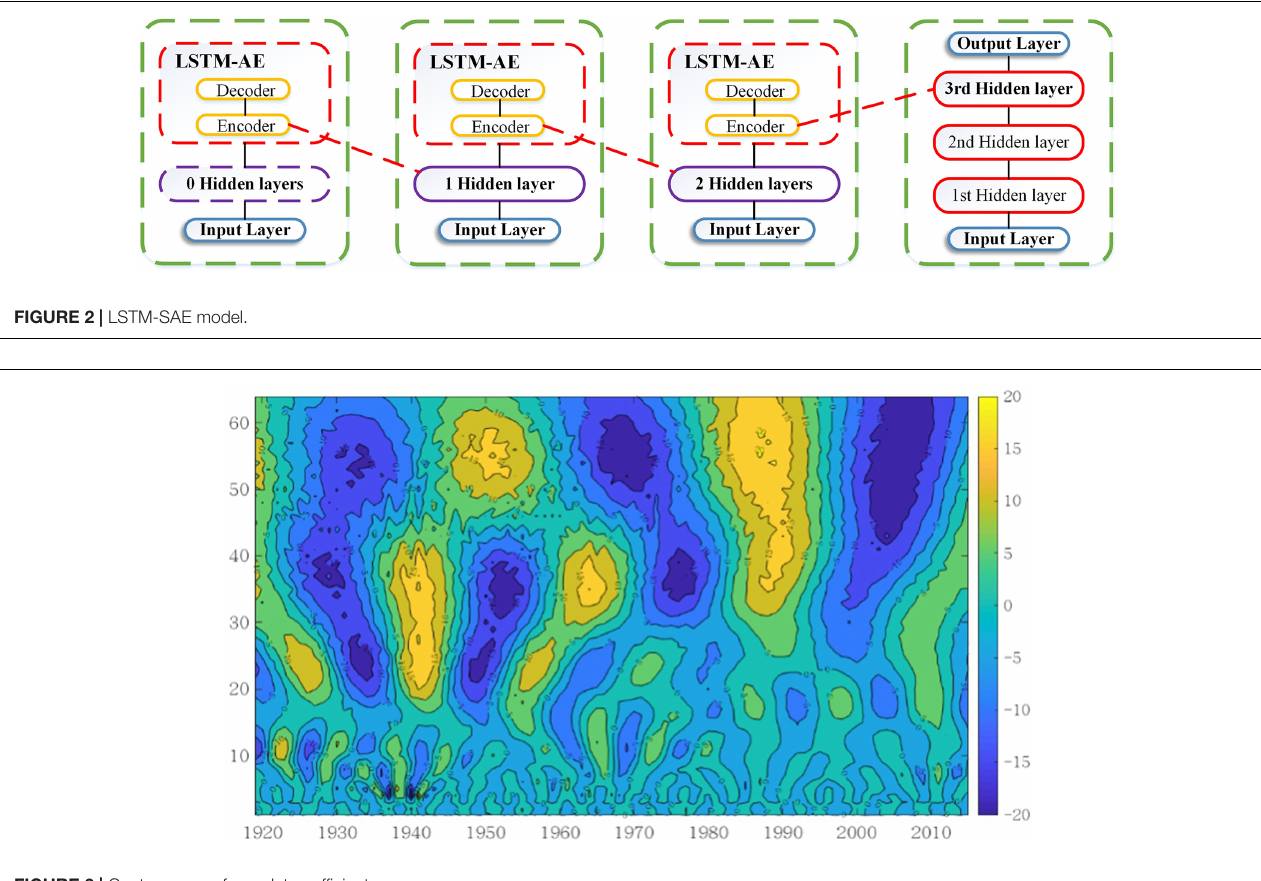
FIGURE 3 | Contour map of wavelet